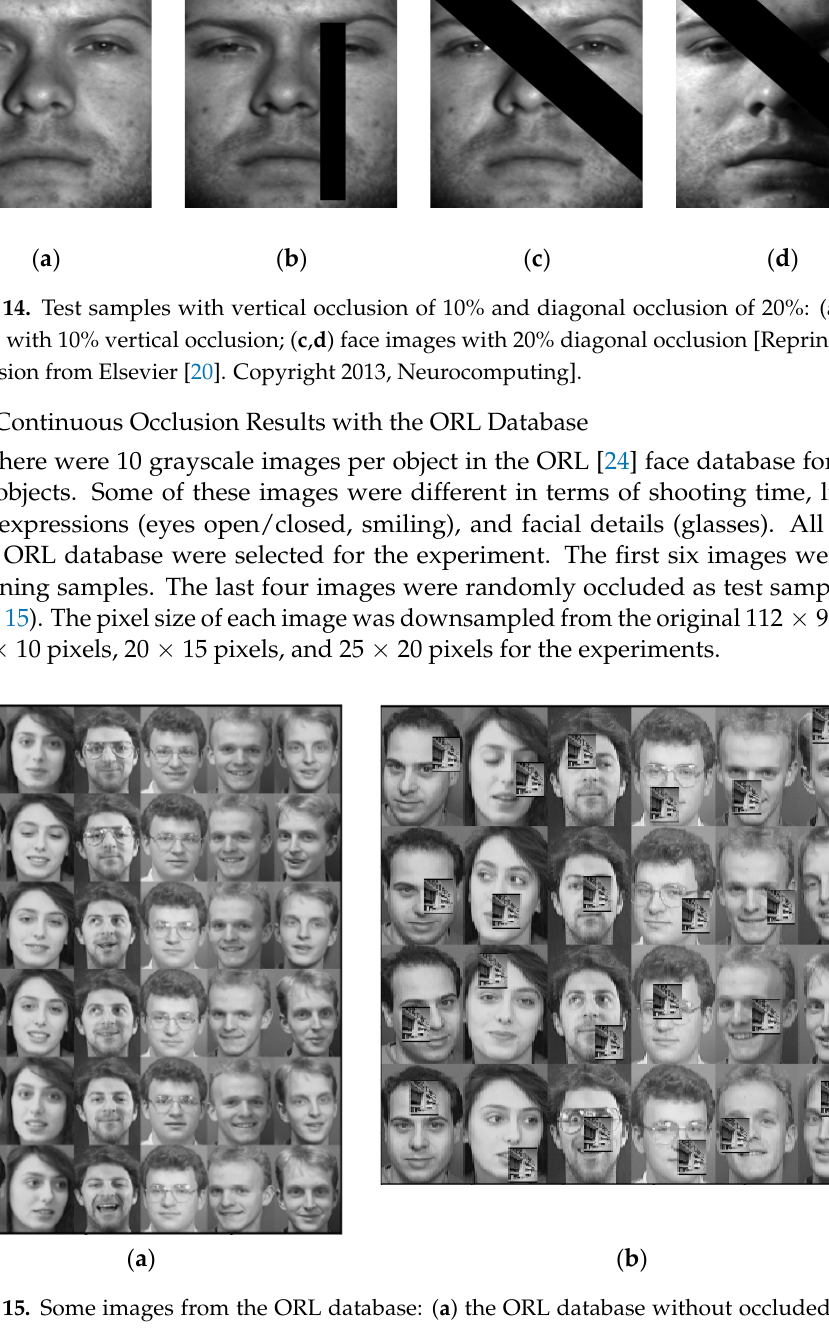
( b ) the ORL database with 10%-occluded images [Reprinted with permission from Elsevier [20].